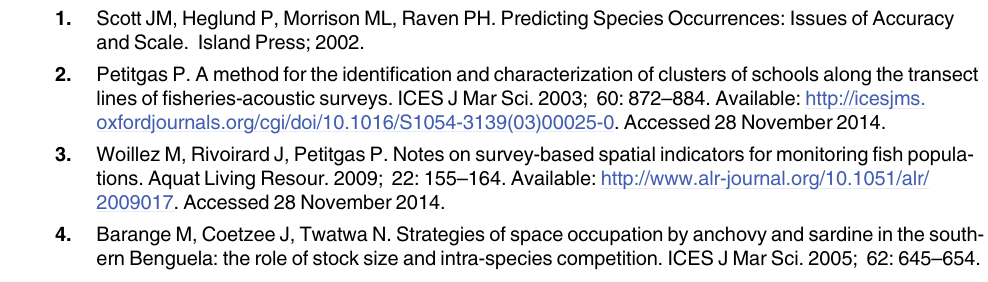
S1 Table. Indicator variogram descriptors for anchovy and sardine. S2 Table. Estimated spatial indicators for anchovy and sardine. S3 Table. PCA scores per species. S4 Table. PCA scores per